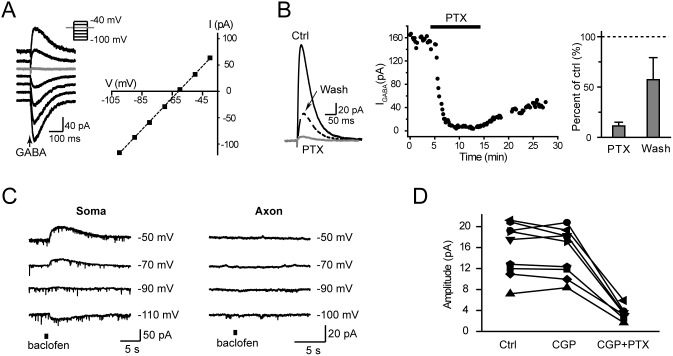
The presence of GABAA (but likely not GABAB) receptors in the axon.A, Reversal potential of GABA responses (IGABA) in the axon bleb. Left, representative currents induced by GABA application at different holding potentials (from –100 to –40 mV). At –60 mV (near reversal potential), GABA application induced no obvious change in baseline current (gray). Right, I-V curve of the GABA-induced responses shown on the left. B, IGABA could be blocked by GABAA receptor blocker PTX. Left, example traces before (black), during (gray) and after (Wash, dashed line) the bath application of PTX (25 µM). Vhold = –50 mV, GABA was applied via iontophoresis. Middle, time course of the effect of PTX. Right, group data showing the change of IGABA during (n = 6) and after (n = 3) PTX application. The dashed line indicates 100% of control. C, Left, currents evoked by puffing baclofen (200 µM), a GABAB receptor agonist, to the soma (16 psi, 15 ms). Right, no response was observed when baclofen was applied to the axon trunk (16 psi, 20 ms). D, Group data showing that GABA-induced currents at the axon blebs could not be blocked by the GABAB receptor antagonist CGP 35348 (100 µM); however, PTX could diminish these responses. Different symbols indicate different cells.